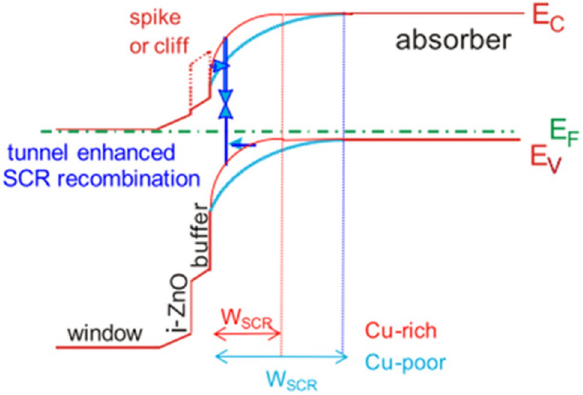
Fig. 3 Simulated energy-band model of a Cu-poor (red) and a Cu- rich (blue) CuInSe 2 solar cell (higher doping of the Cu-rich absorber is assumed). The horizontal arrow indicates the tunnel recombination process due to high doping levels. Permission granted by the authors to reuse the figure, Copyright© 2013 Society of Photo-optical Instru- mentation Engineers (SPIE)